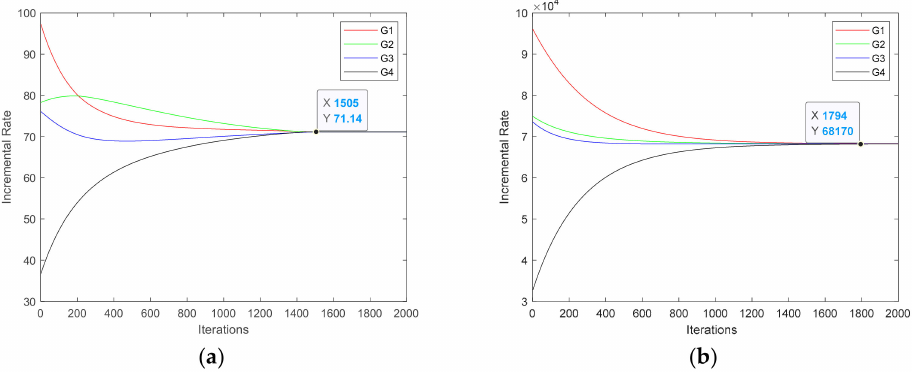
Figure 14. The rate of micro-increase. ( a ) The rate of micro-increase in fixed-time consistency at the random delay; ( b ) The rate of micro-increase in classical consistency at the random delay.